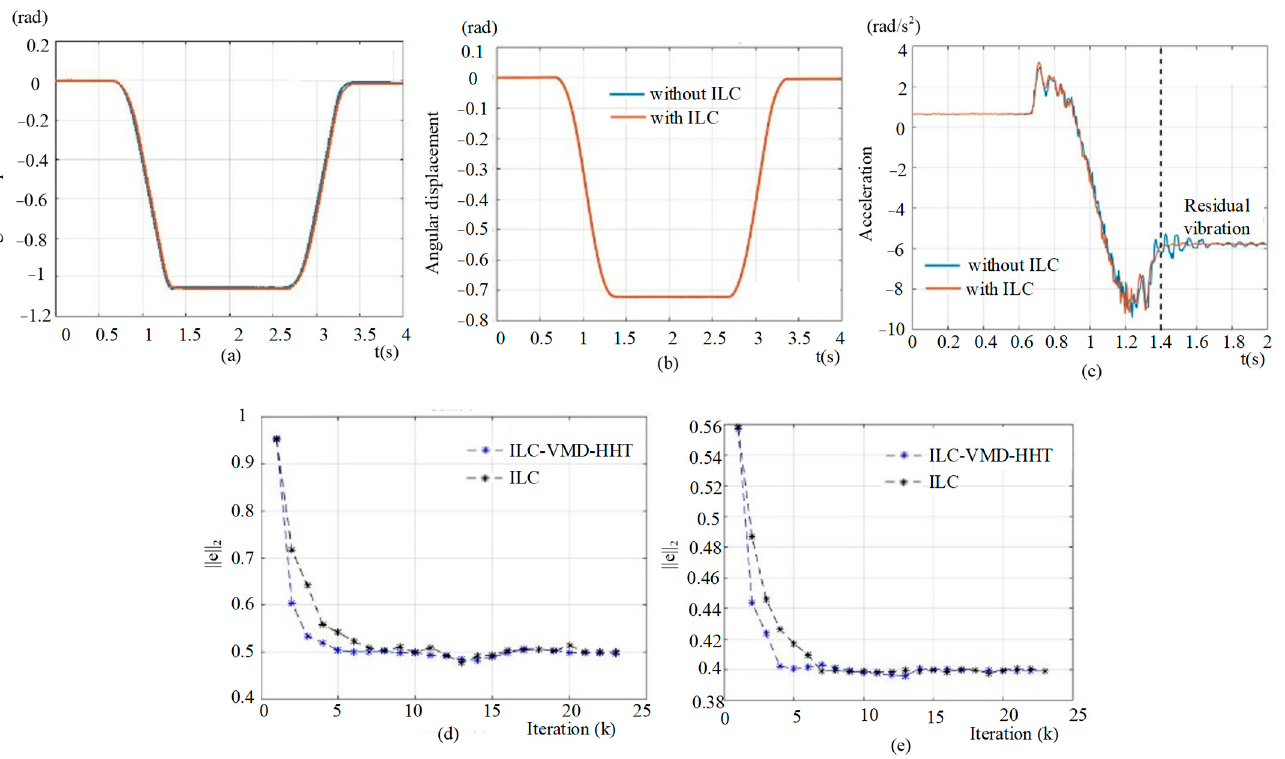
Figure 12. Effects of ILC and VDM-HHT. ( a ) Link-side angular displacement of the first joint. ( b ) Link-side angular displacement of the second joint. ( c ) Acceleration of the second joint. ( d ) L2 norm of the error of the first joint. ( e ) L2 norm of the error for the second joint. Table 6. Maximum tracking error and L2 norm of the error of an input-based ILC in experiments. Iteration No.